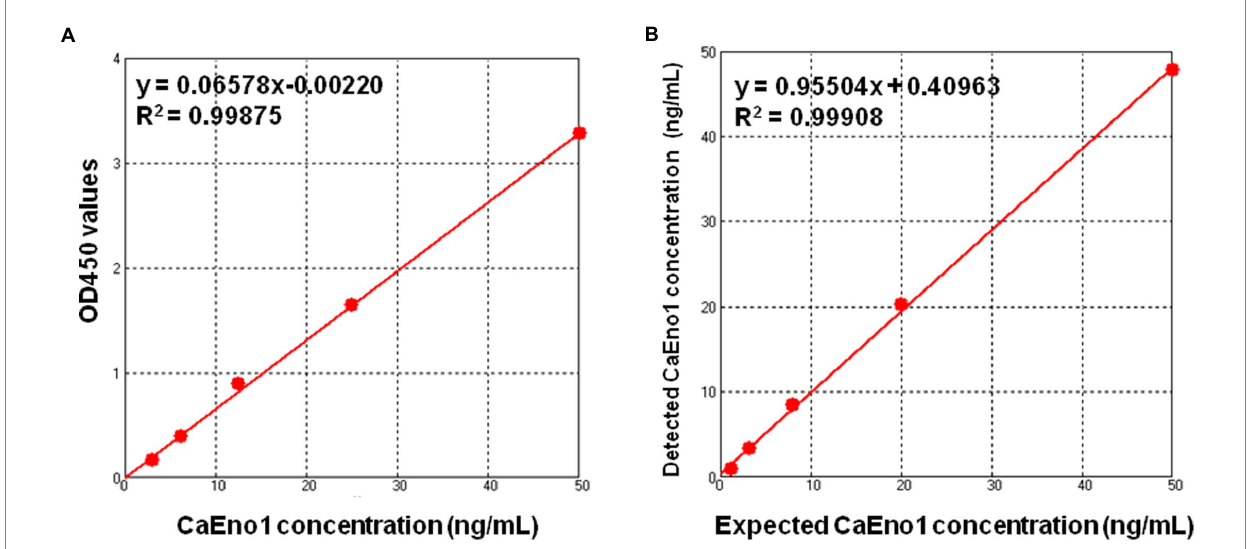
FIGURE 2 Standard curve (A) and linear range (B) of the one-step DAS-ELISA assay for the quantitative detection of CaEno1 in rabbit